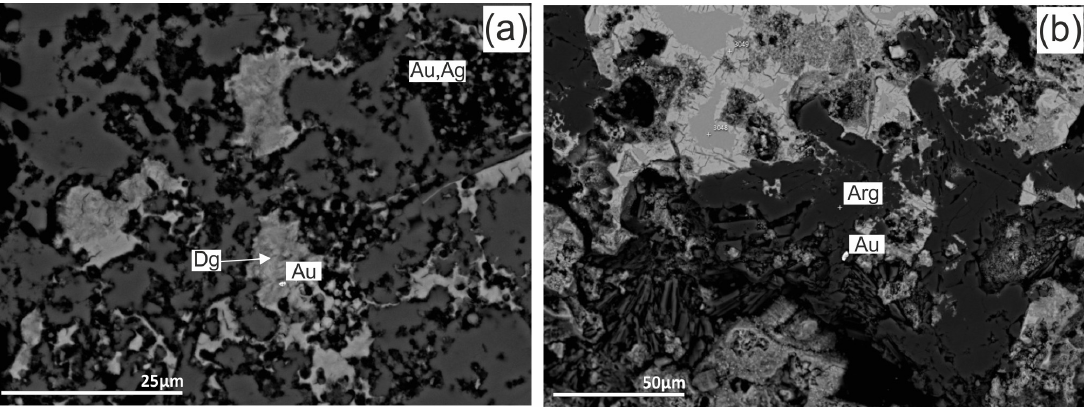
Figure 14. Au minerals of altered sulphide breccia with aragonite cement. BSE photographs. ( a ) Electrum (Au,Ag) in the secondary Cu-sulphide (digenite); ( b ) Native gold in aragonite cement. However, samples from 293 station do not contain Au and any accessory